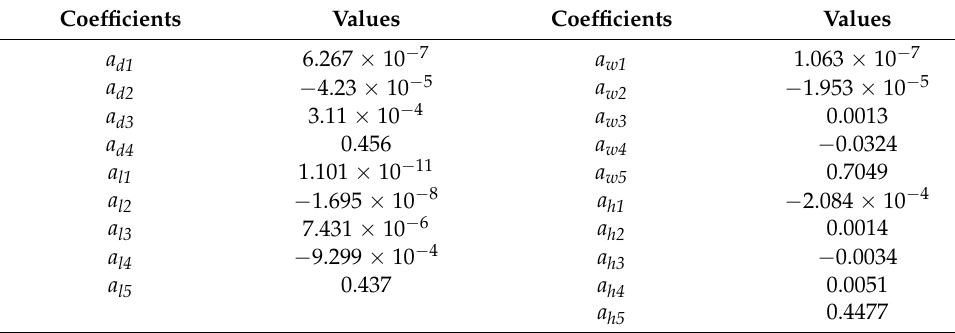
Table 2. Coefficients for the shield structure.